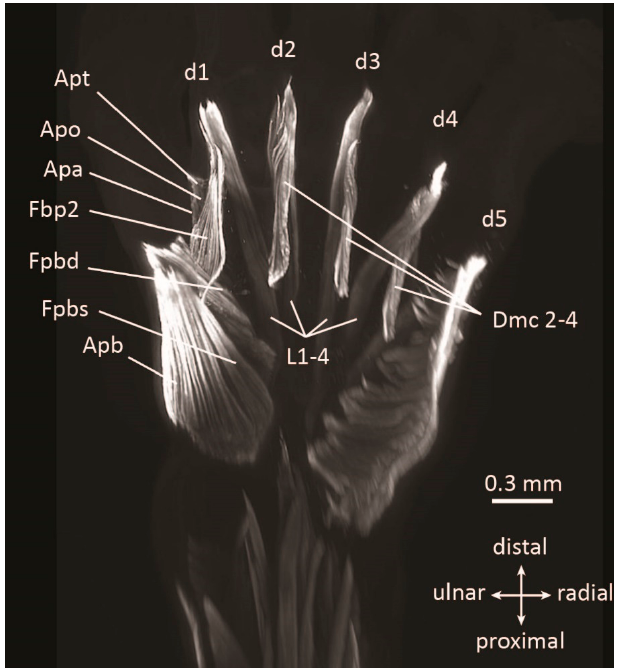
Figure 4. Ventral view of hand of CR51 mm (11 GW) fetus stained with anti-MHC antibody showing muscle anatomy and atavistic dorsometacarpales muscles (Dmc 2-4). Other muscle abbreviations: Apa, adductor pollicis accessorius; Apb, abductor pollicis brevis; Apo, adductor pollicis oblique head; Apt, adductor pollicis transverse head; Fbp2, flexor brevis profundus 2; Fpbd, flexor pollicis brevis deep head; Fpbs, flexor pollicis brevis superficial head; and L, lumbricales. Modified from Diogo et al. [60]. Table 1. Order of appearance of forelimb and hindlimb muscles in human ontogeny and phylogeny. First column shows crown-rump length (CR) when the muscle is visibly distinct from other muscles. Second column shows most inclusive clade in which the muscle is present: Tetrapoda (also present in salamanders); Amniota (also present in “lizards”); Mammalia (also present in monotremes); Theria (also present in opossums); Euarchontoglires (also present in rats); and Homo (only present in modern humans). With some exceptions, the muscles that appear earlier in embryonic development also appear in successively larger taxonomic groups including humans. Modified from Diogo et al.